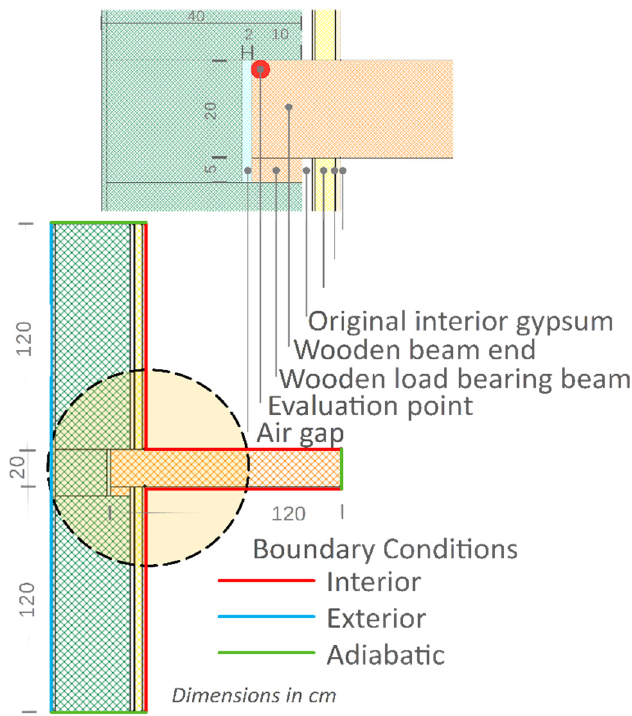
Figure 10. Considered 2D hygrothermal model, evaluation point, and boundary conditions.